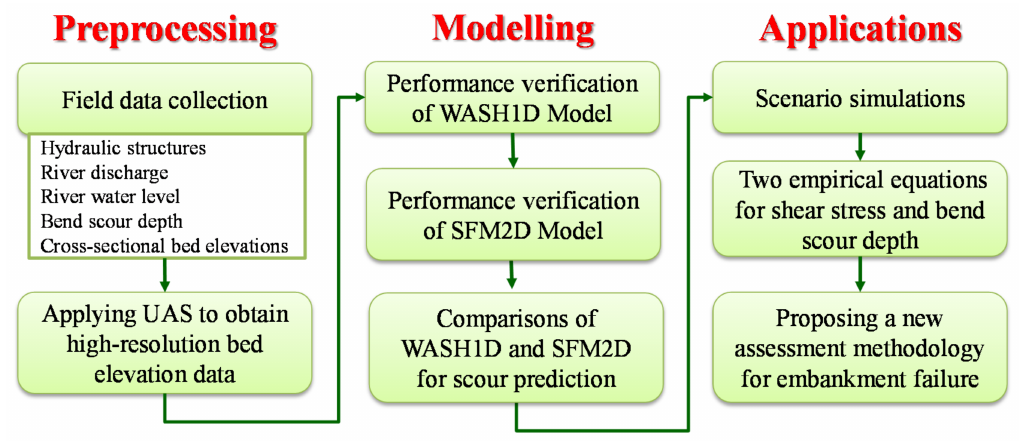
Figure 2. Methodological flow chart for bend scour